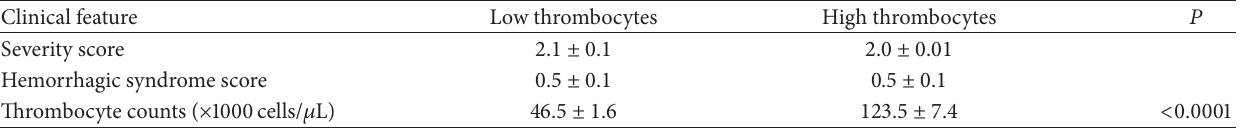
Table 6: Clinical presentation of NE patients with high ( > 50,000) and low ( < 50,000) thrombocyte counts.